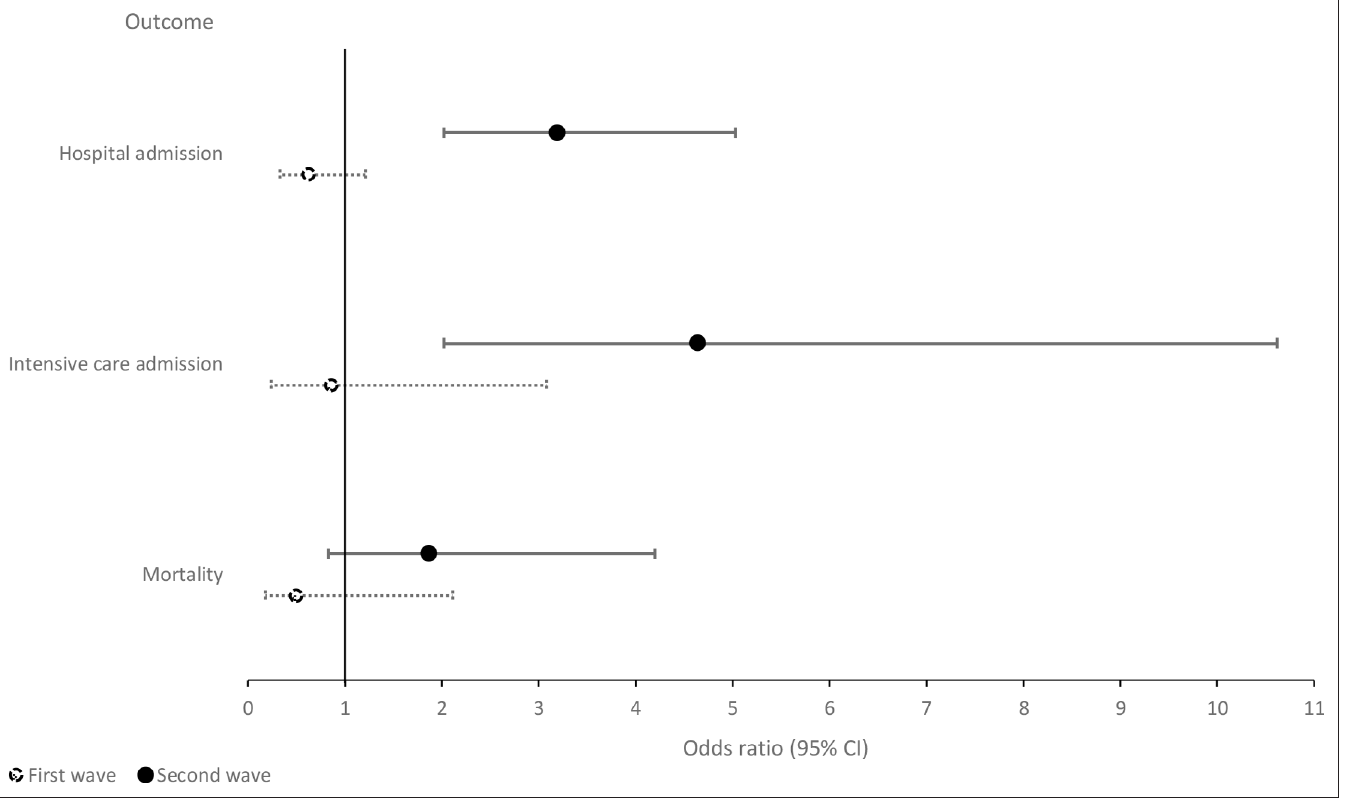
Figure 2 Observed outcome after antibiotic prescription for SARS- CoV- 2. BMI = body mass index. CI = confidence interval. Multivariate logistic regression was performed with pooled imputed data and outcomes were adjusted for all risk